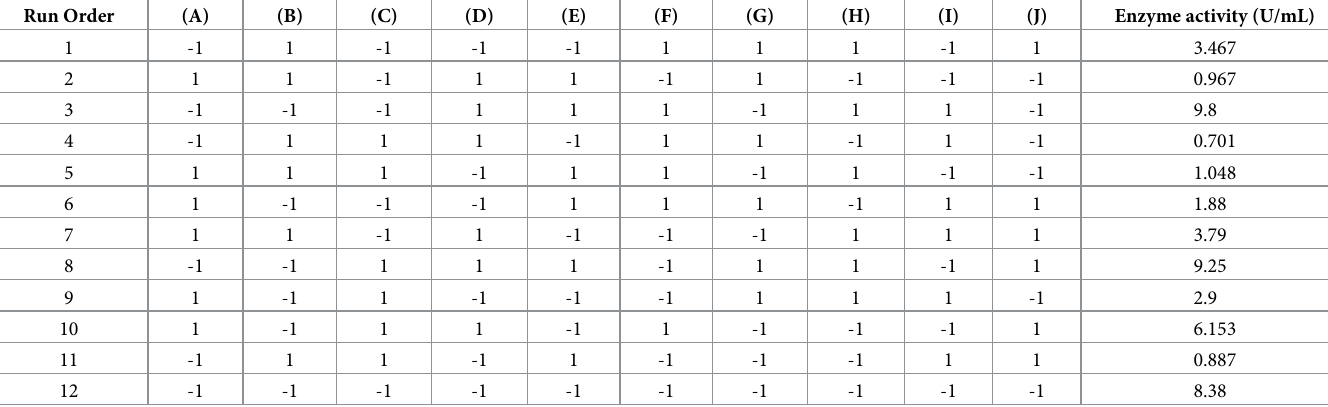
Table 7. Placket Burman experimental design for PHB depolymerase production with the bacterial strain Aeromonas caviae Kuk1-(34) sp. Run Order